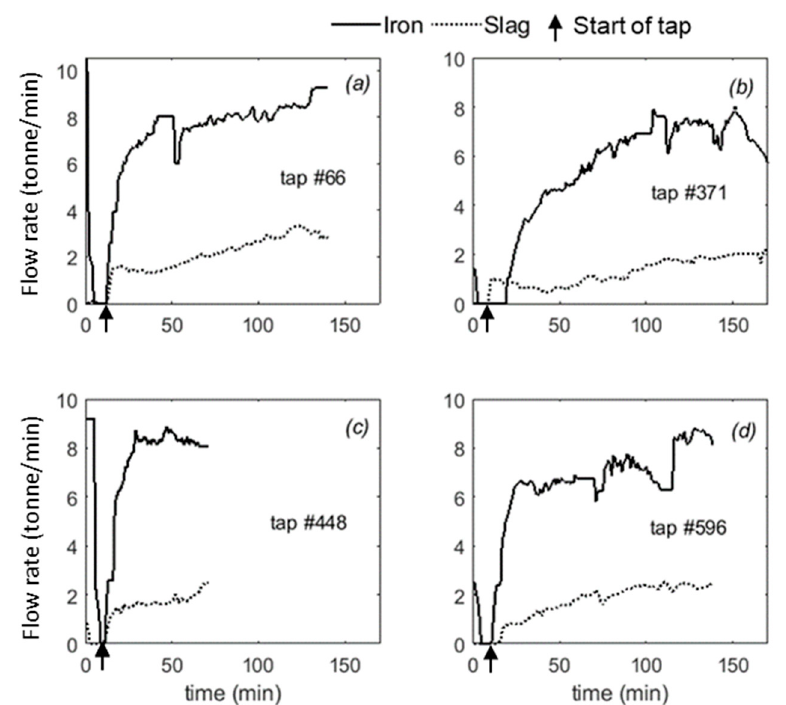
Figure 2. Examples of liquid outflow patterns from the Data set 2: ( a ) zero slag delay and 135 min tap duration, ( b ) negative slag delay and 170 min tap duration, ( c ) zero slag delay and 70 min tap duration, and ( d ) positive slag delay and 140 min tap duration.